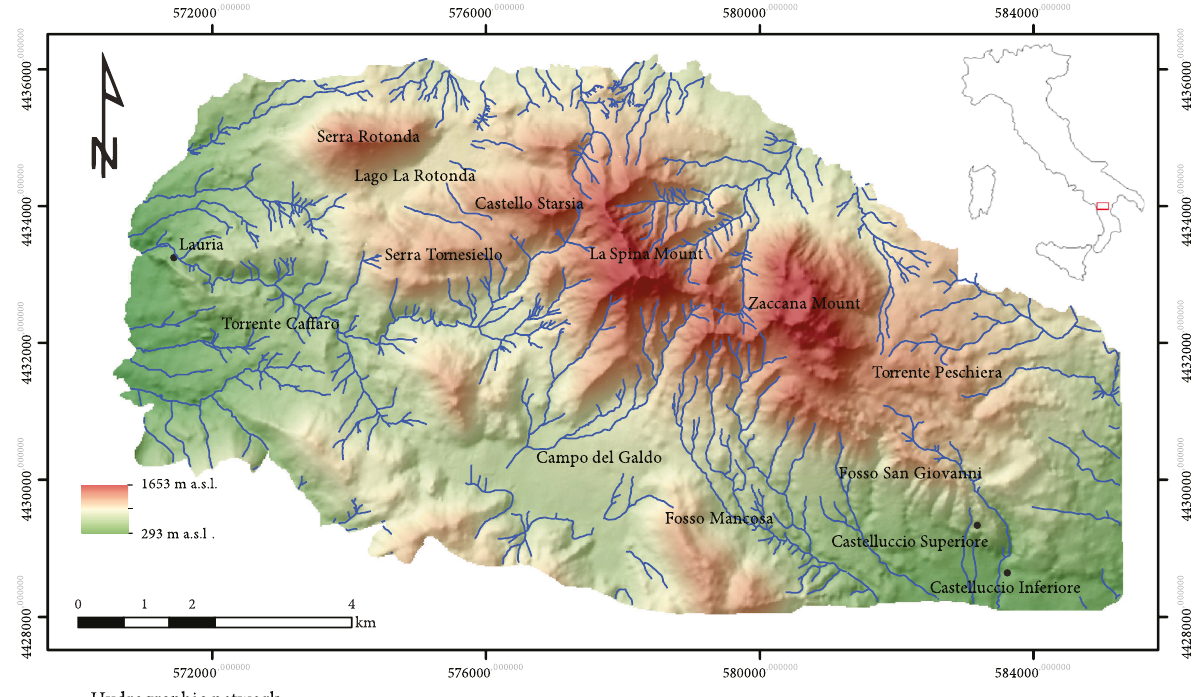
Figure 1: Geographic location, digital elevation, and hydrographic network of the study